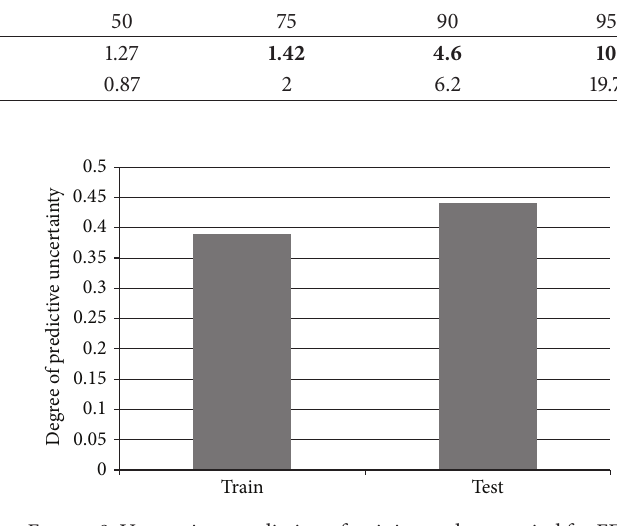
Figure 8: Uncertainty prediction of training and test period for FF-